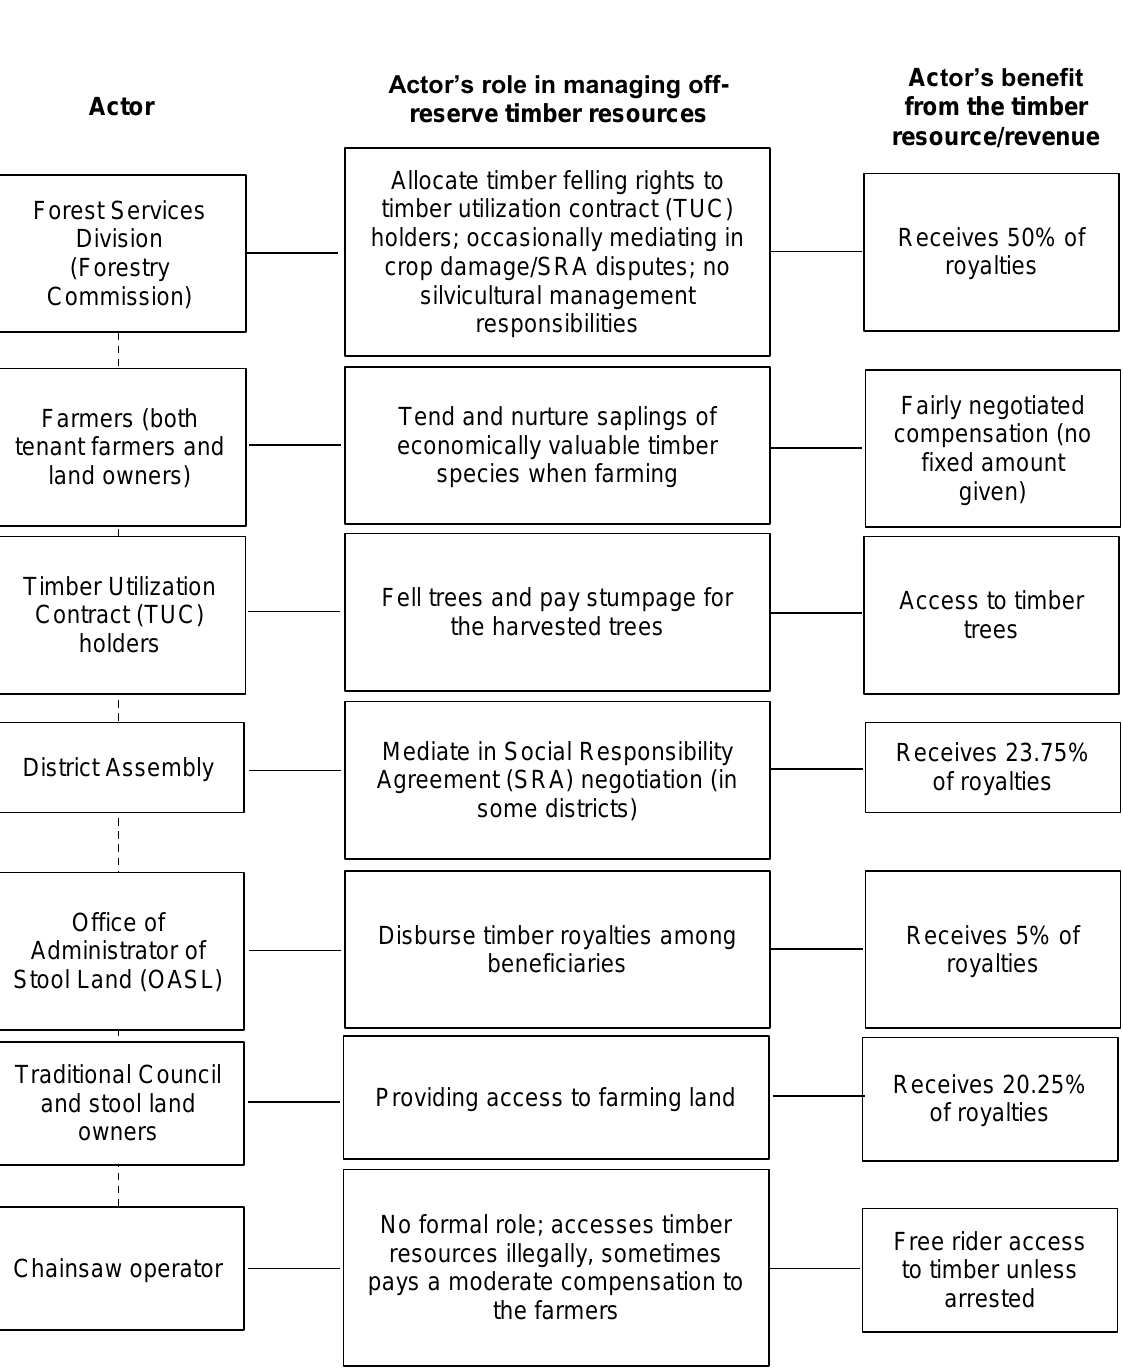
Figure 1. Distribution of off-reserve timber benefits over the actors